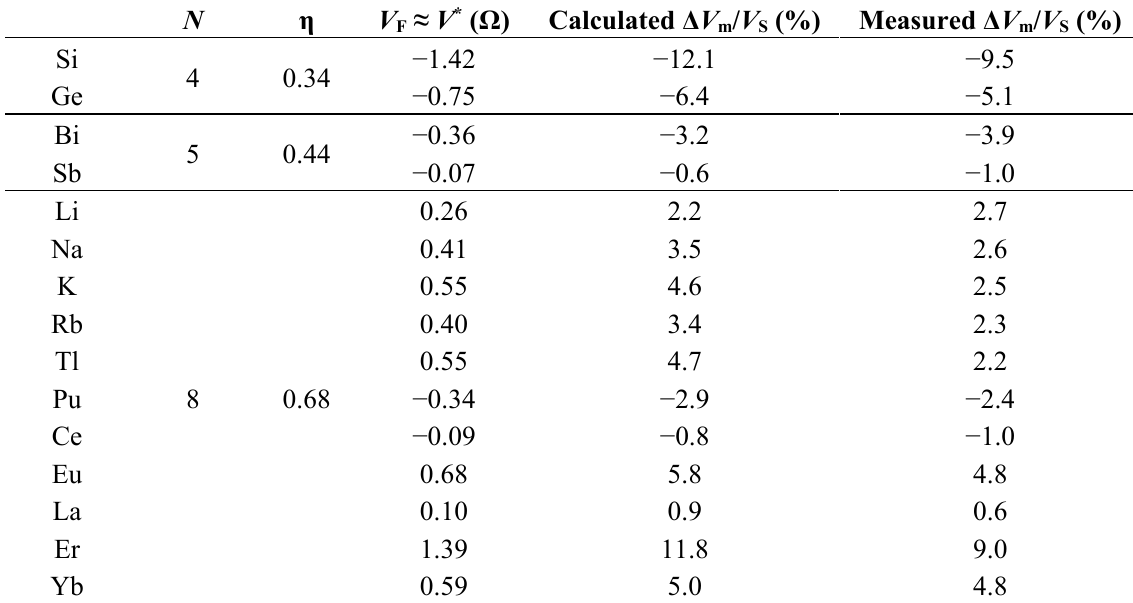
Table 2. The number of the first coordinating atoms in crystals N [31], the packing density in crystals η [31], the vacancy formation volume V F as estimated from the activation volume of self-diffusion in crystals V * [32] in terms of atomic volume Ω, the calculated volume change during melting Δ V m / V S = V F /( N Ω/η) [29], where V S is the volume of crystals before melting, and the measured Δ V m / V S data